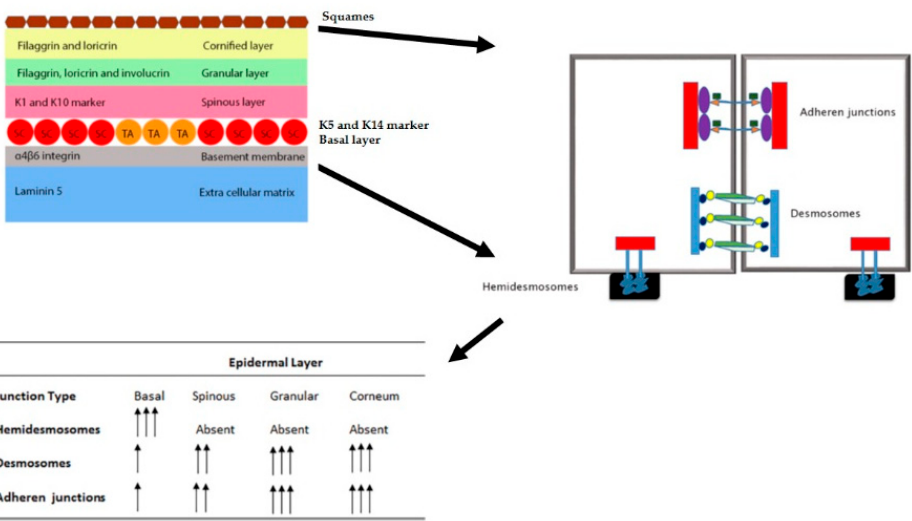
Figure 1. Epidermal stem cell biomarkers and epidermal stratification. Epidermal stratification of skin is a finely orchestrated process that maintains skin architecture as well as homeostasis. Epidermal stem cells are found at specific locations in the skin and specifically those found in the interfollicular epithelium (IFE), and basal cells undergo division to give rise to a population of cells with lineage commitment. The primary division of epidermal stem cells (ESCs) give rise to two sets of cells; one that retains ESC sternness and the other with limited division and lineage commitment called transit amplifying (TA) cells. TA cells after a few rounds of division produce cells that are destined to form the supra basal layers. Based on the cell fate destination, the TA originated cells express markers specific to epidermal layer occupancy. Such that cells expressing K5 and K14 biomarkers occupy the immediate first layer above the basal layer and consist of cells with a spinous membranous structures. Further, as the cells get pushed upward, the expression of K1 and K10 biomarkers place cells in the granular layer with deposition of granules inside the cells. The induction of filaggrin and loricrin along with keratin create cellular condensation and layer compaction contributing to the cornification of the stratum corneum. As cells are pushed from the basal layer to the top of the epidermis, the number as well as the type of junctions change mediating keratinocyte flexibility and plasticity and tissue integrity. In the basal layer, the number of adheren junctions are fewer and hemidesmosomes are more. Such a framework provides the possibility for keratinocyte migration and epidermal turnover. The basement membrane (BM) is tethered to the extra cellular matrix (ECM) by integrin molecules in conjunction with laminin 5 of the ECM matrix and mediate basal cell stability with the BM through integrin-keratin connections. As the cells move upward both desmosome and adheren junctions increase and their connection to intracellular keratin further strengthens the tissue architecture. As shown in the figure, the following symbols represent the respective epidermal markers and ECM proteins. Red rectangle, actin; green small square, p120; orange triangle, β -catenin; purple oval; α -catenin, irregular blue shape, E-cadherin; elongated blue rectangle, keratin; irregular dark green shape, desmoglein; irregular light green shape, desmocollin; dark blue circle, desmoplqakins; yellow circle plakoglobin; squiggle blue shape, integrin and black rectangle, basement membrane. SC = Stem cells and TA = transit amplifying cells. The arrows in the table indicate the number of specific-type of junctions in the respective epidermal layers. A single arrow indicates the presence of very few specific-type of junctions; a double arrow indicates a few more and triple arrows indicate an even greater presence of these junctions in the respective epidermal layers. Stem cells (SCs) of the epidermis exits in specific pockets known as bulges and are found in the hair follicle, interfollicular epithelium (IFE) and sebaceous glands [1] (Table 1). Identification of ESCs in these regions have been supported by population enrichment studies in murine models, where epidermal slow-cycling stem cells are screened from other cells based on label retention of bromodeoxyuridine or [3H] thymidine. Similarly, commitment of the SC lineage has been assessed through transgenic